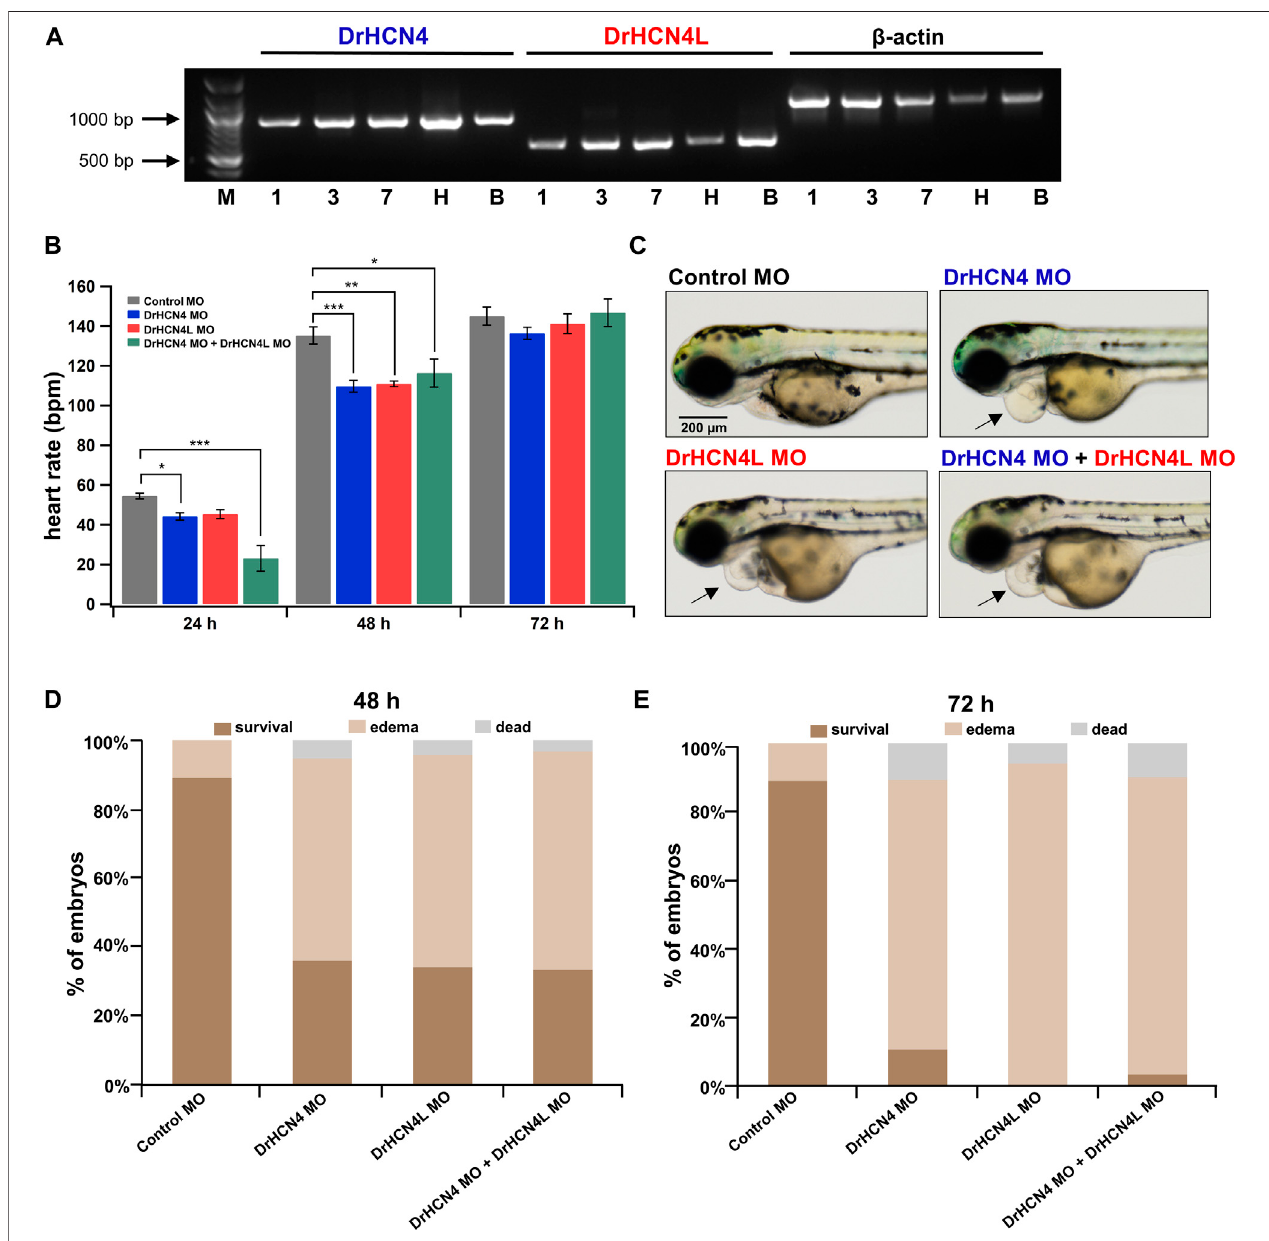
FIGURE 6 | Effects of HCN4 channel knockdown on zebra fi sh. (A) Expression of DrHCN4 and DrHCN4L in one (1), three (3), and seven (7) day embryos/larvae as well as in the heart (H) and brain (B) of adult fi sh was con fi rmed by RT-PCR. Arrows indicate the DNA ladder markers of 1,000 bp and 500 bp. (B) Heart rates at 24, 48, and72 hareshowninbargraphsfor200 μ MMO-injectedzebra fi shembryos:controlMO( n =20),DrHCN4MO( n =10),DrHCN4LMO( n =10),andmixedDrHCN4and DrHCN4L MO ( n = 10). Statistical analysis was performed by Dunnett ’ s test. (C) Representative examples of zebra fi sh injected with control MO, DrHCN4 MO, DrHCN4L MO, and mixed DrHCN4 and DrHCN4L MO. Zebra fi sh with DrHCN4 MO, DrHCN4L MO, and mixed DrHCN4 and DrHCN4L MO showed pericardial edema (black arrows). Bar, 200 μ m. (D) Ratios of normal embryos, pericardial edema, and death at 48 h after injection of 200 µM MO: control MO ( n = 136), DrHCN4 MO ( n = 75),DrHCN4L MO( n =34),andmixedDrHCN4andDrHCN4LMO( n =30). (E) Pericardialedemaanddeathratiosat72 hafterinjectionof200 µMMO.ControlMO( n = 136), DrHCN4 MO ( n = 75), DrHCN4L MO ( n = 34), and mixed DrHCN4 and DrHCN4L MO ( n = 30).